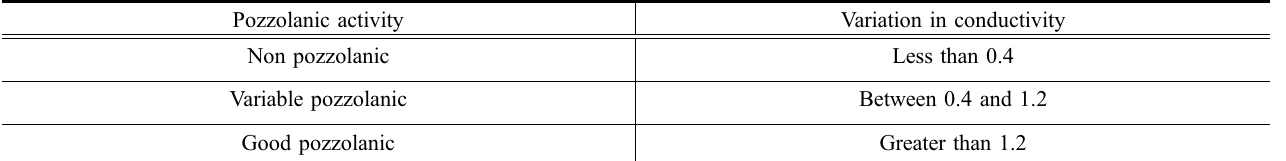
Table 2 Evaluating pozzolanic activity by electrical conductivity measurement (Luxa´n et al.